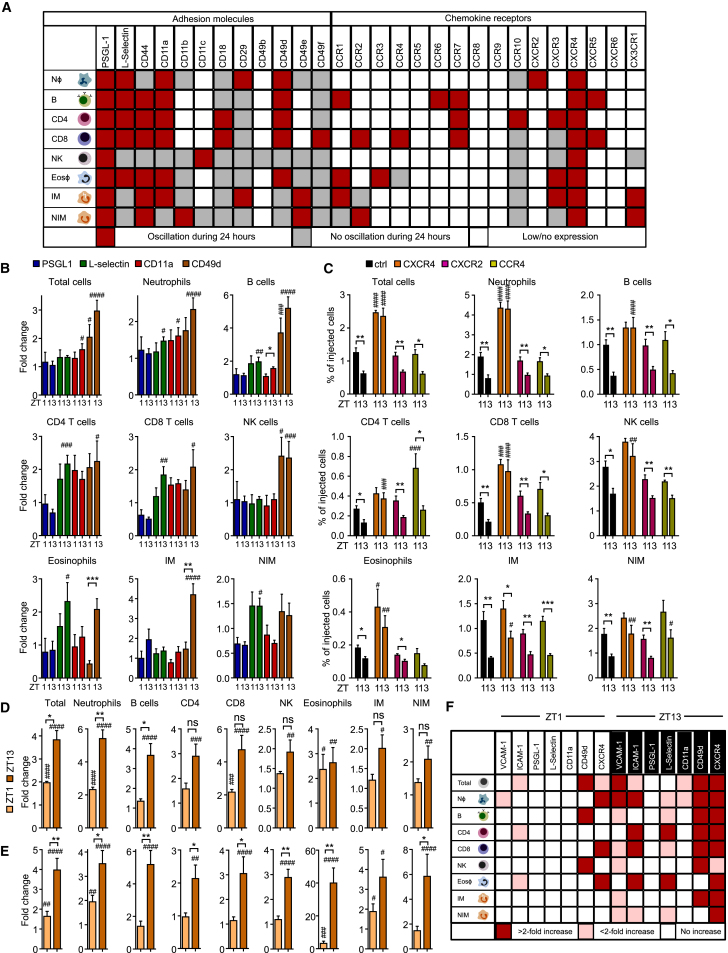
Leukocyte-Subset-Specific Oscillations in Pro-migratory Molecules(A) Map of rhythmic protein expression of adhesion molecules and chemokine receptors in blood leukocyte subsets (n = 3–6 mice with 4–6 time points measured each; one-way ANOVA).(B) Adoptive transfer of ZT1 and ZT13 donor cells to recipients treated with functional blocking antibodies directed against the indicated molecules at ZT1 and ZT13. Cell numbers are normalized to ZT1 and ZT13 controls (n = 3–12 mice; one-way ANOVA followed by Dunnett comparison to control groups and unpaired Student’s t test for comparisons between ZT1 and ZT13 groups).(C) Adoptive transfer of donor cells to recipients treated with antagonists against the indicated molecules at ZT1 and ZT13 (n = 3–10 mice; one-way ANOVA followed by Dunnett comparison to control groups and unpaired Student’s t test for comparisons between ZT1 and ZT13 groups).(D) Fold change of donor cells remaining in recipient blood at ZT1 and ZT13 after anti-VCAM-1 and anti-ICAM-1 antibody treatment, respectively, in comparison with numbers of isotype antibody controls. (n = 3 or 4 mice; one-way ANOVA followed by Dunnett comparison to control groups and unpaired Student’s t test for comparisons between ZT1 and ZT13 groups).(E) Endogenous blood leukocyte numbers after CXCR4 antagonist treatment (n = 3 or 4 mice; one-way ANOVA followed by Dunnett comparison to control groups and unpaired Student’s t test for comparisons between ZT1 and ZT13 groups).(F) Overview of functional blocking effects on adoptively transferred leukocyte subsets in blood targeting the indicated molecules at ZT1 and ZT13 (n = 3–12 mice; one-way ANOVA followed by Dunnett comparison to control groups).∗p < 0.05, ∗∗p < 0.01, ∗∗∗p < 0.001, ∗∗∗∗p < 0.0001; #, ##, ###, #### indicate significance levels analogous to those of control groups. All data are represented as mean ± SEM. ns, not significant. See also Figure S3 and Table S2.